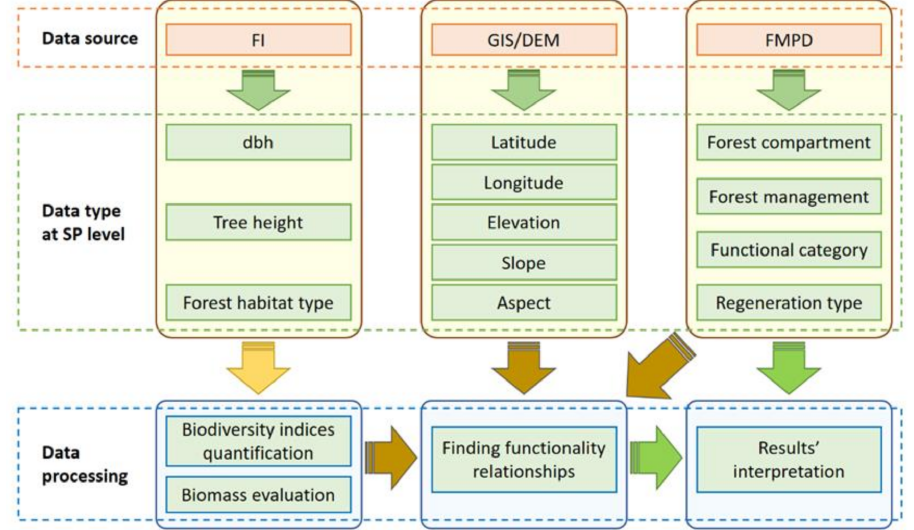
Figure 2. Methodological framework used in data collection and